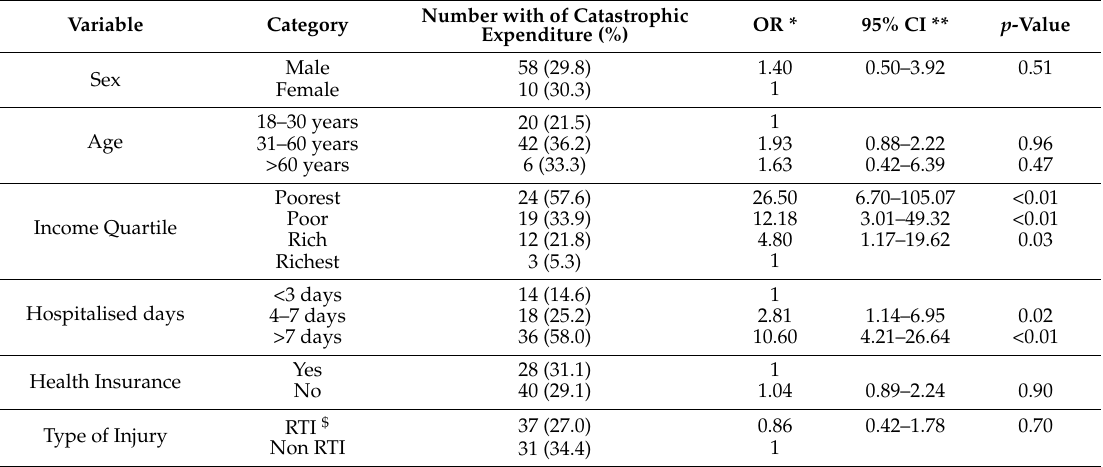
Table 3. Prevalence of catastrophic expenditure during hospitalization and its risk factors.